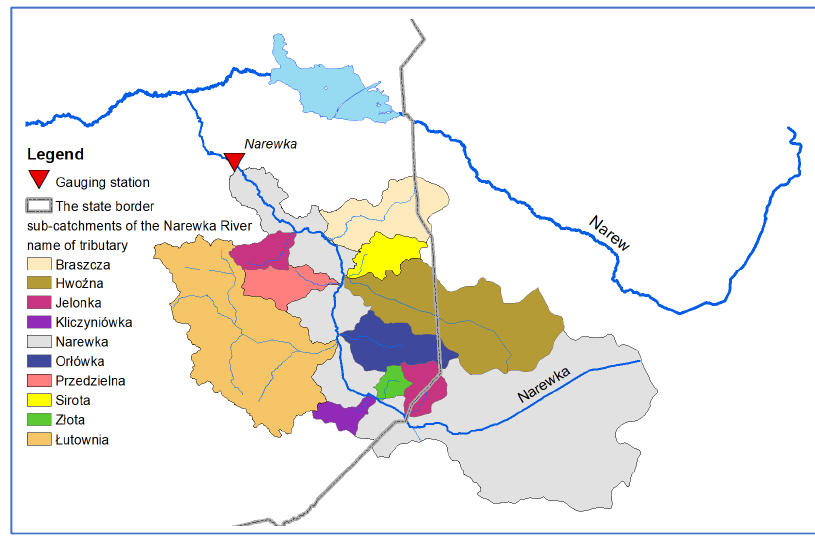
Figure 2. River network of Narewka River until the Narewka water